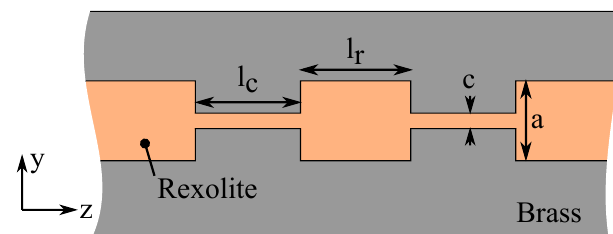
Figure 52. Cross section a NRD resonator which is coupled by below cutoff lines, as presented in [50].